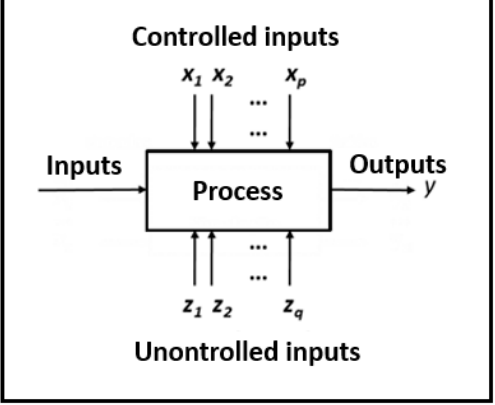
Figure 3. Resistances formed during spot welding of manganese boron steel galvannealed hot stamping.